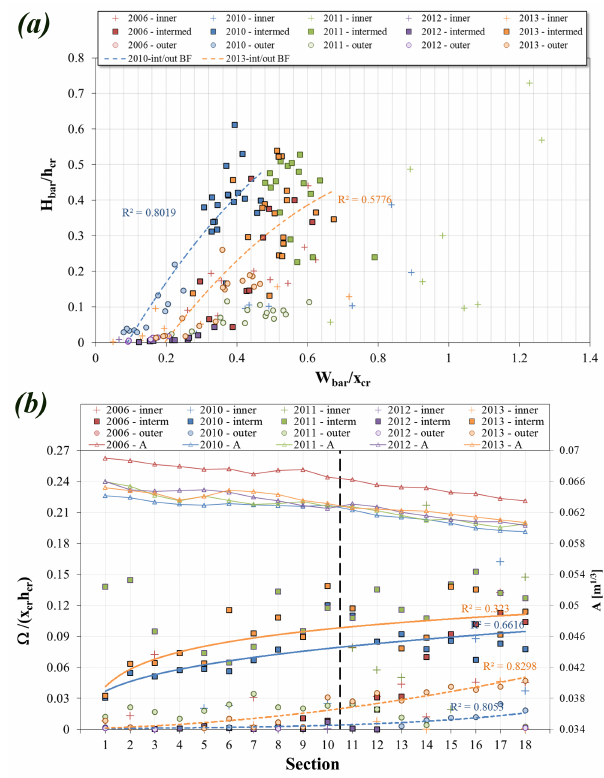
Figure 7. Dimensionless bar features: (a) bar height against bar width and (b) longshore distribution of bar cross-shore area (dashed and solid thick lines represent best-fit curves) and A parameter (solid thin lines and triangles). The vertical black dashed line repre- sents the Rotonda